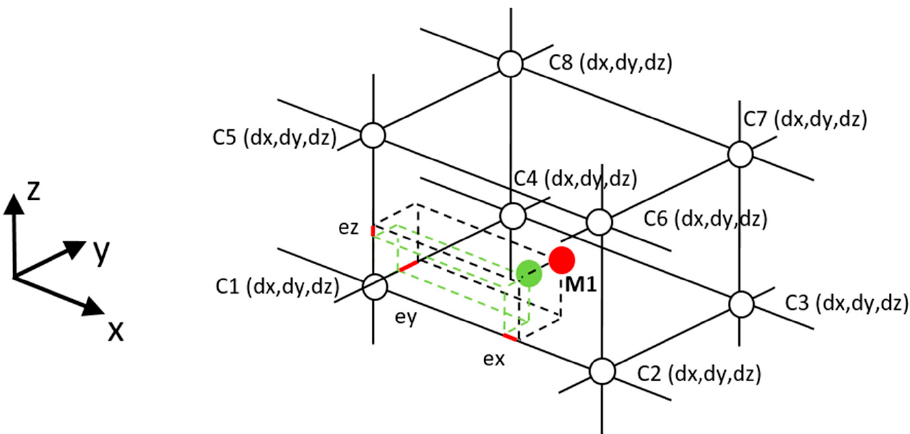
Figure 1. Measured point M1 surrounded by the correction mesh. The nominal and real positions of the measured point are marked in green and red, respectively.